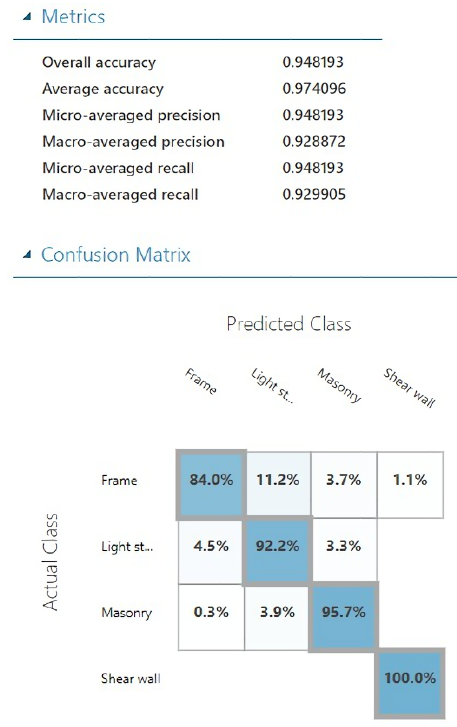
Figure 21. Prediction accuracies and confusion matrix for the case of Daxing downtown.